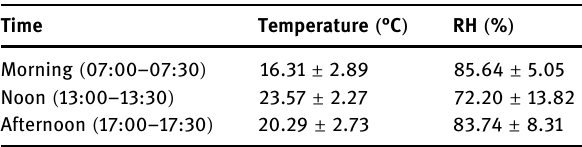
Table 1: Temperature and RH at vegetative phase Time